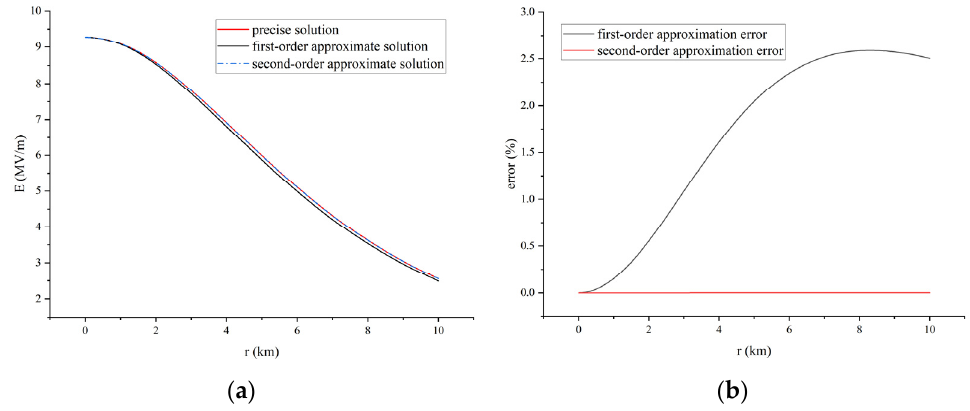
Figure 2. ( a ) Comparison of the first-order approximate solution, second-order approximate solution, and exact solution, while z = 0. ( b ) Relative error of first-order approximation and second-order approximation while z = 0.